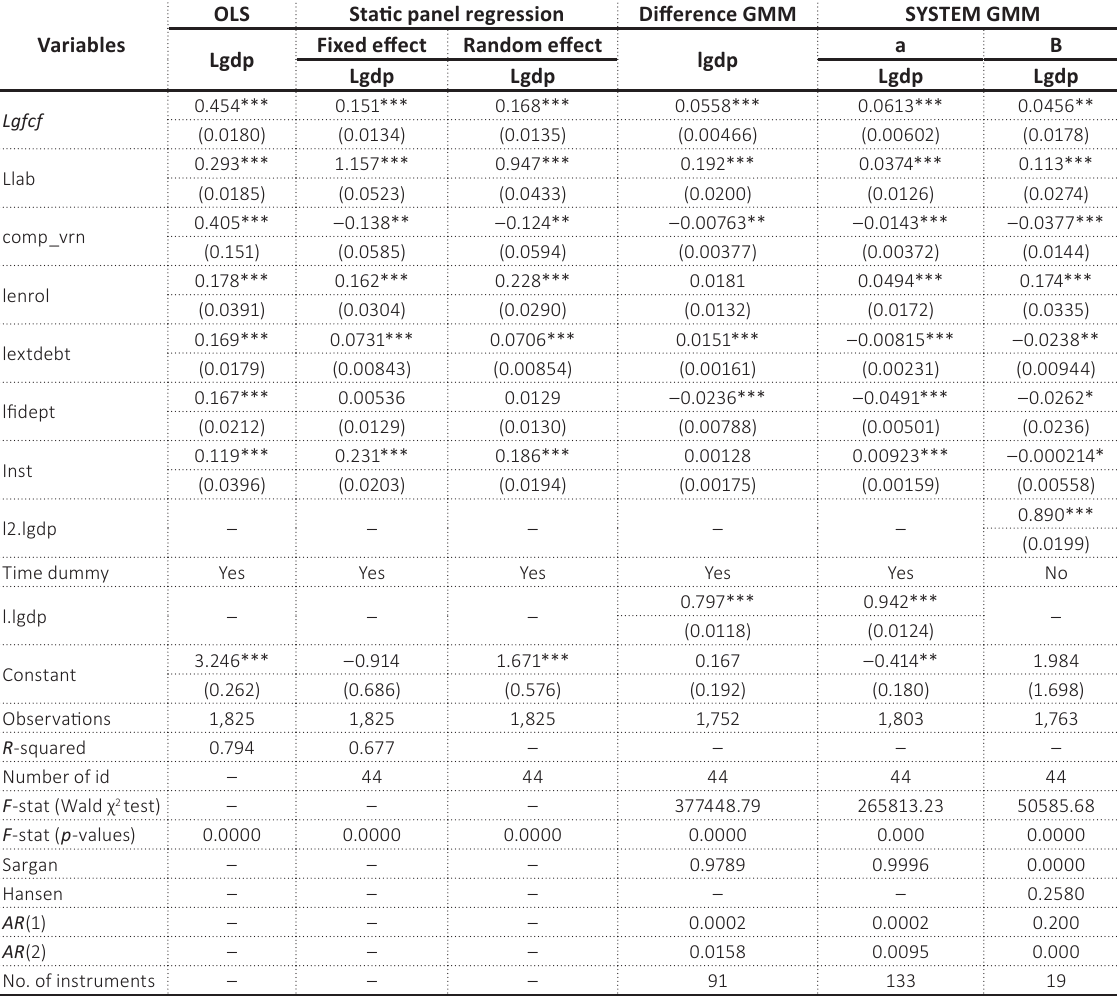
Source: Computed using Stata